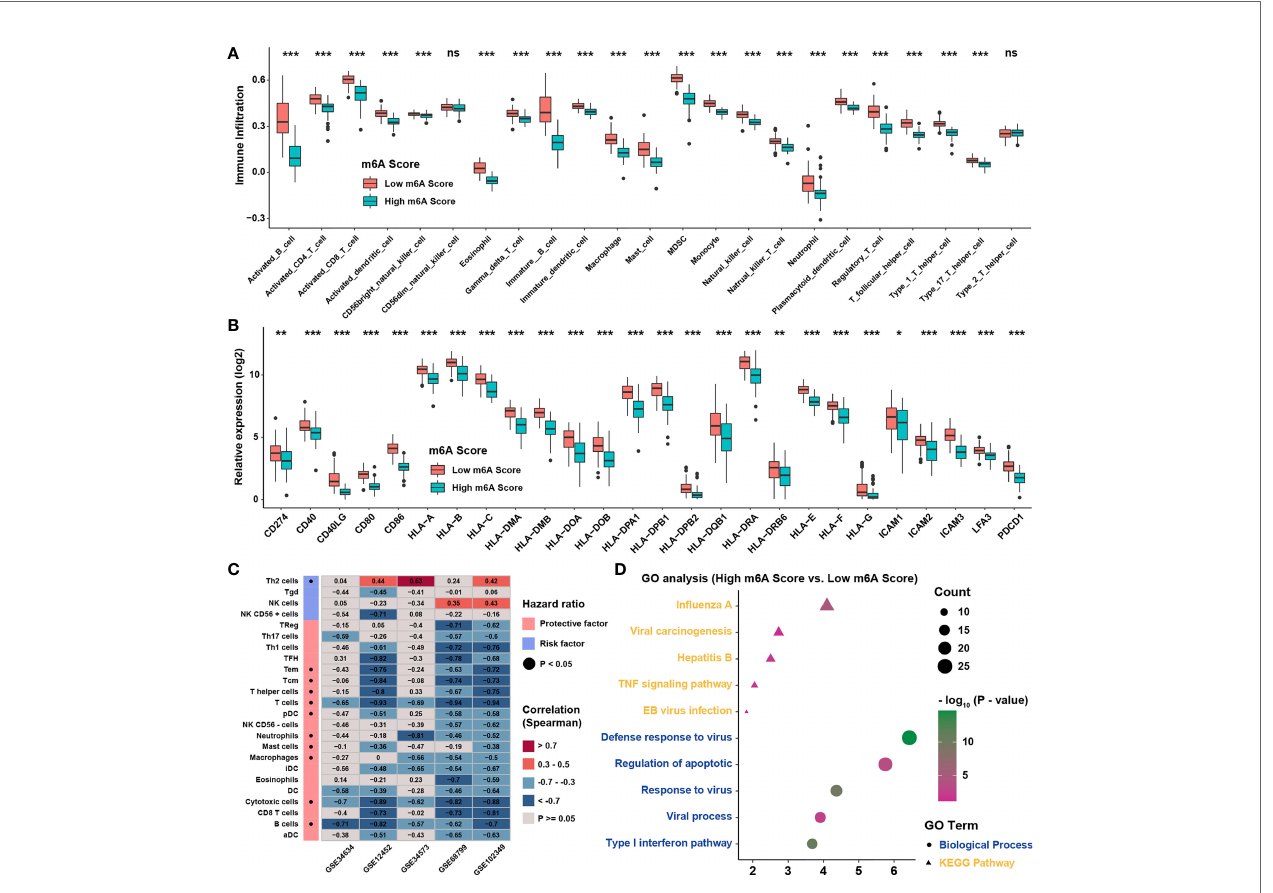
FIGURE 6 | TME in fi ltration characteristics of m6A score. (A) The abundance of TME in fi ltration cell assessed by immune cell signature 2 in different m6A score groups. (B) The abundance of MHC molecules, costimulatory molecules, and adhesion molecule in different m6A score groups. (C) Correlations between m6A score and TME in fi ltration in 5 independent NPC datasets using Spearman analysis. (D) GO analysis for differentially expressed genes between m6A score groups. *P < 0.05; **P < 0.01; ***P < 0.001; ns, no signi fi